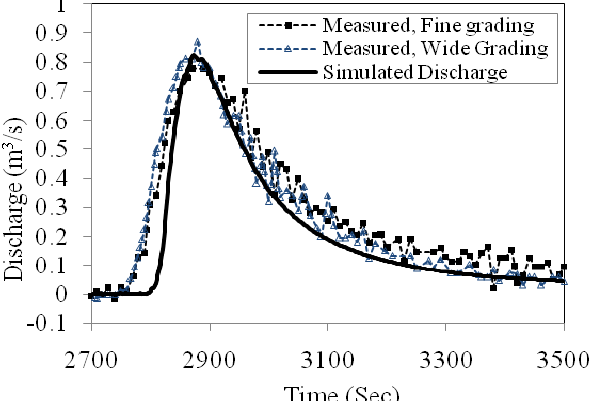
Figure 9. Measured and simulated breach flow discharges.